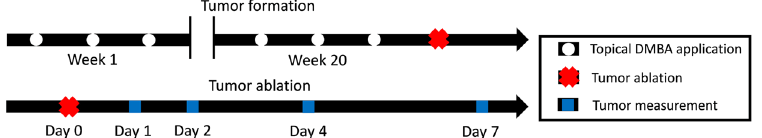
Figure 1. Study design for assessing effects of injection rate and ethyl cellulose concentration on therapeutic efficacy in vivo . Squamous cell carcinomas were induced in the hamster cheek pouch through topical application of DMBA 3X per week until tumors formed and reached a volume of 100 mm 3 (approximately 20 weeks). Tumors were then injected with 50 µ L of either ethanol or 3% ethyl cellulose-ethanol solution at a rate of 0.1, 1.0, 10 or 100 mL/hr. After ablation, tumor volume was measured at 1, 2, 4, and 7 days after treatment.